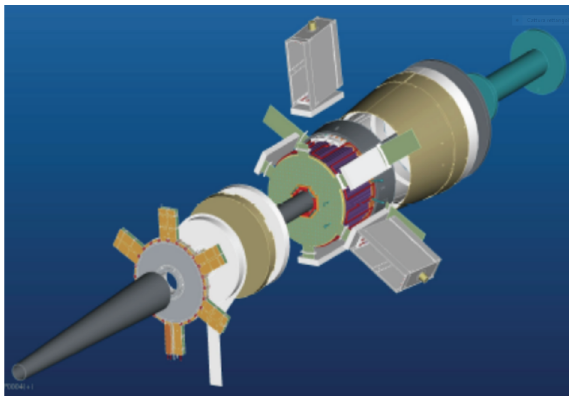
Figure 4. The Forward Tagger system. The FT provides electron and high energy photon detection in a range of polar angles θ = 2 . 5 ◦ − 4 . 5 ◦ and is fully integrated into the operation of